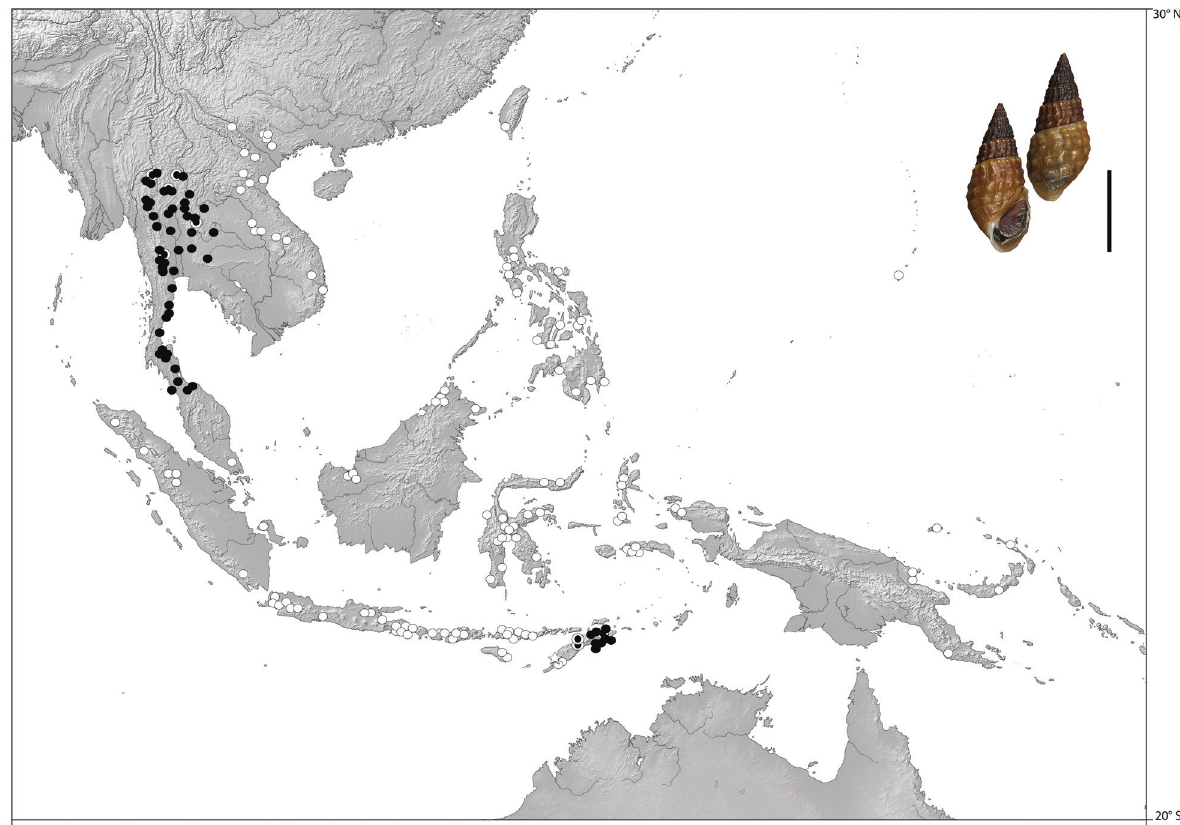
Figure 1. Distribution of the freshwater thiarid snail Tarebia granifera (Lamarck, 1816) across its range in Southeast Asia, with the focus on occurrences in Thailand, contrasted with type and topotypical material from the island of Timor. Asteriks: type locality of “ Melania ” granifera Lamarck, 1816, reconstructed to originate from near Kupang in western Timor (see text for more details); black dots: sequenced material used in this study; white dots: shell material from museum collections analysed and literature records; white dots with black dot inside: wet material preserved in